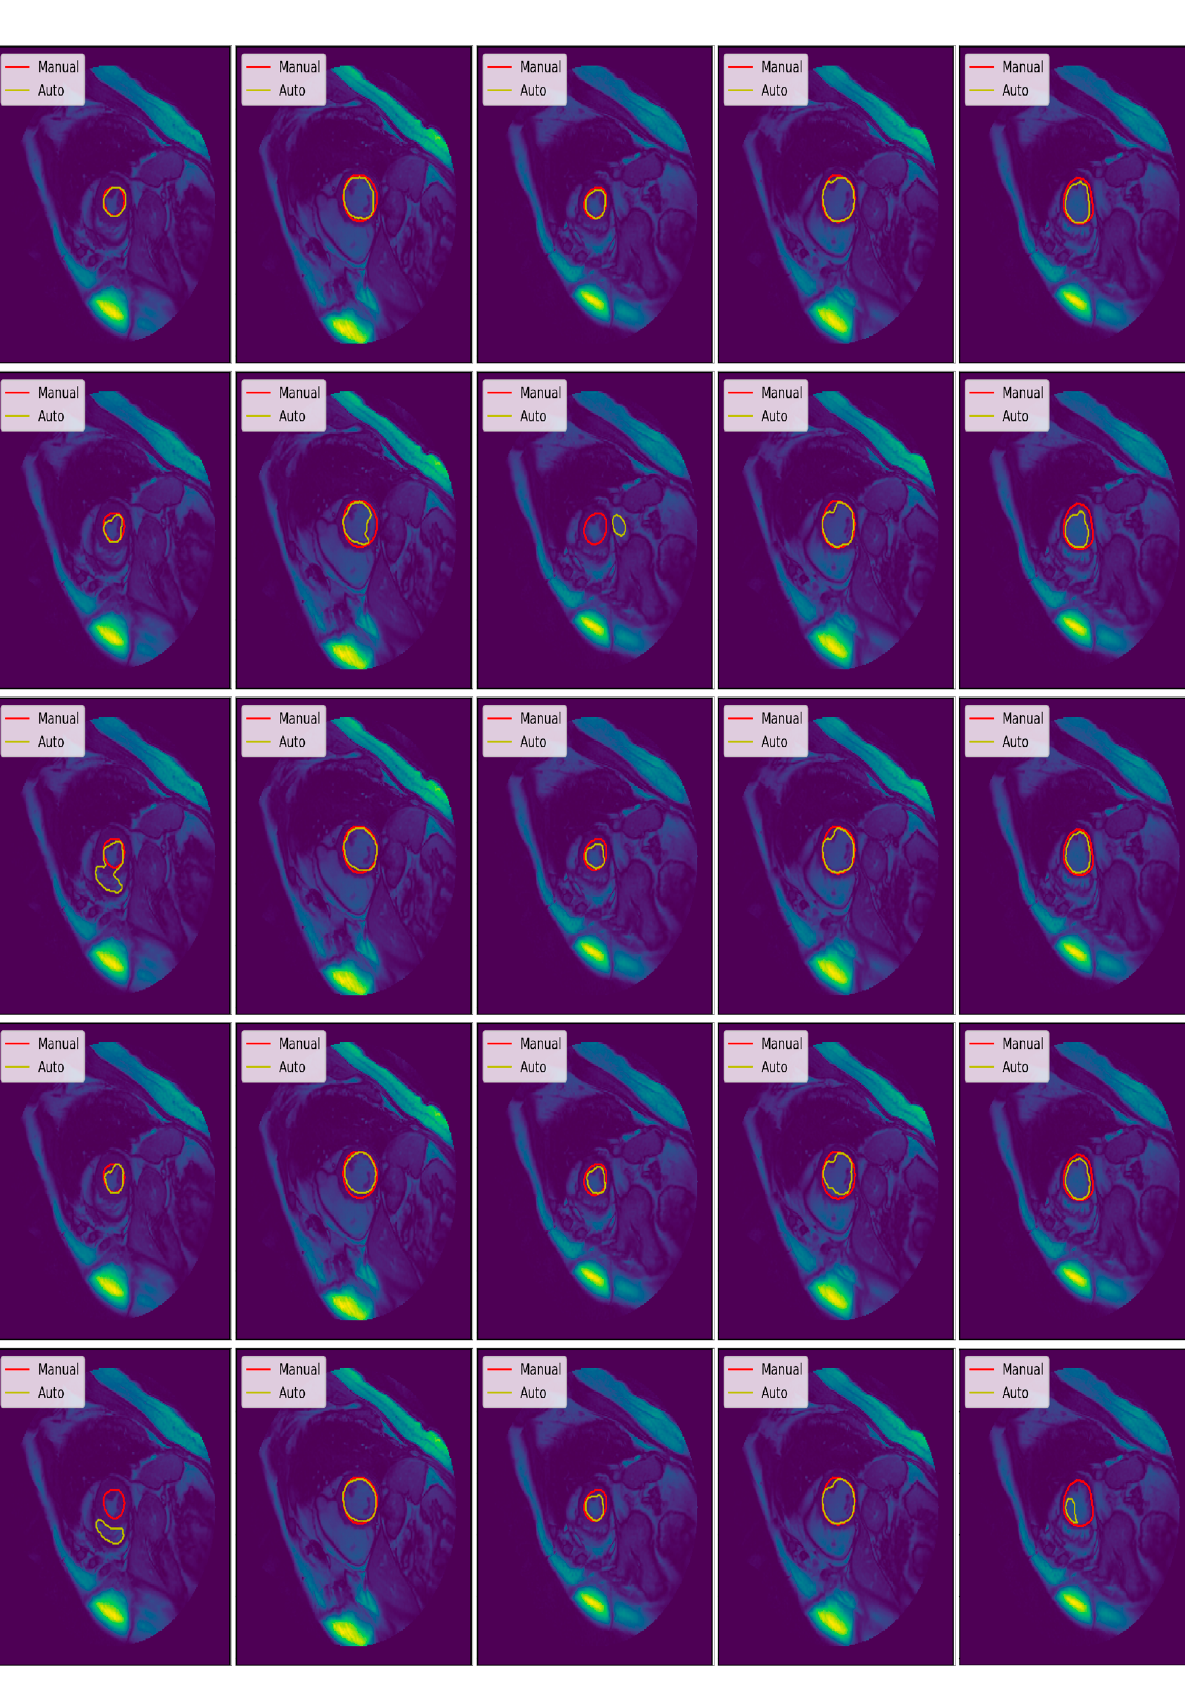
Figure 17. Automatic and manual segmentation results of the epicardium from the testing set of a normal subject (SC-N).